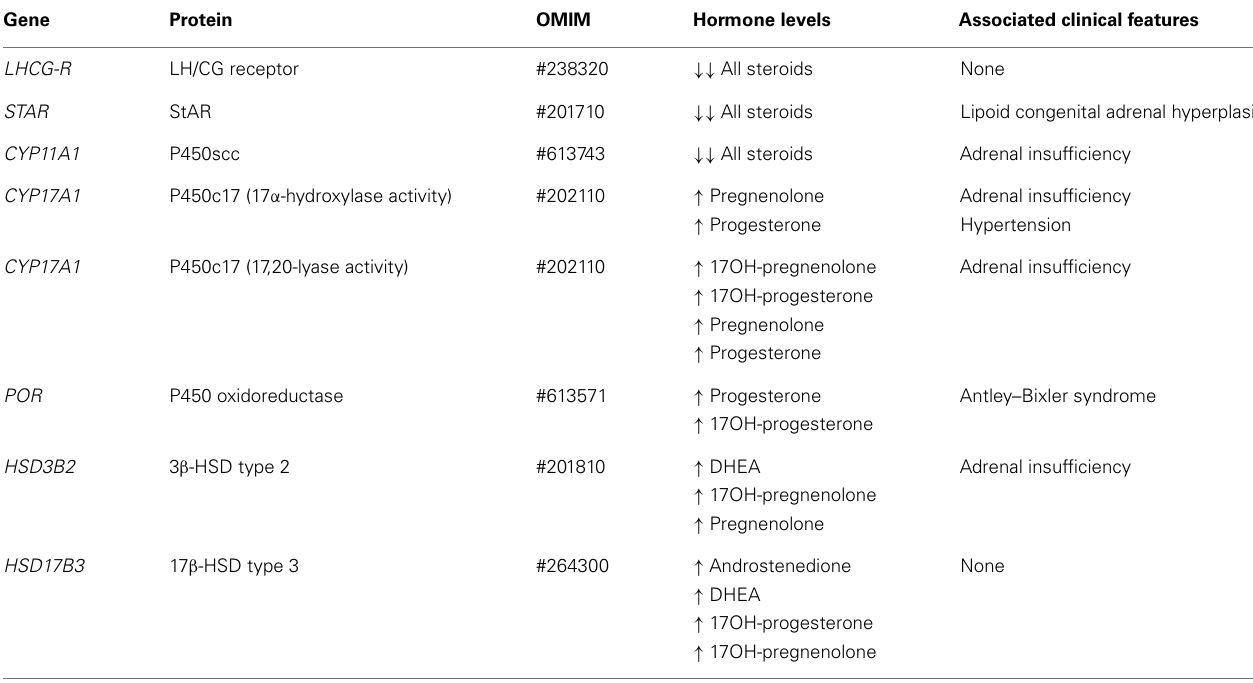
Table 3 | Clinical features in male patients with fetal-onset primary hypogonadism with Leydig cell-specific (steroidogenic)